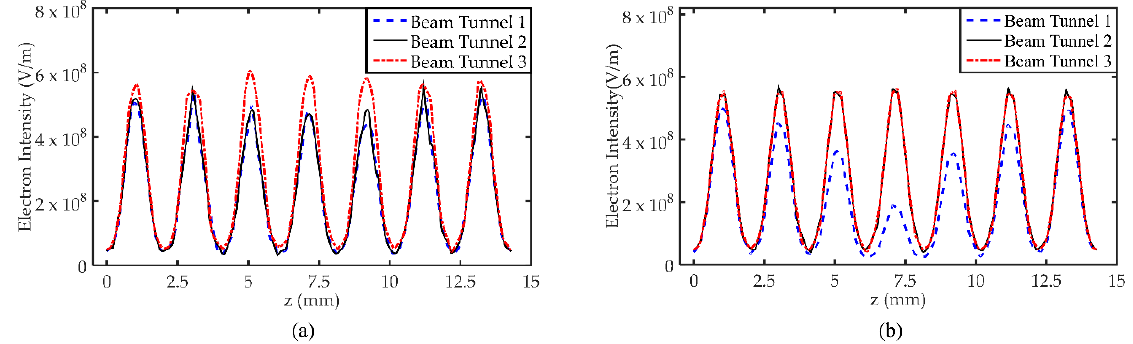
Figure 6. ( a ) Schematic of field intensity curves of device-0. ( b ) Schematic of field intensity curves of device-5.